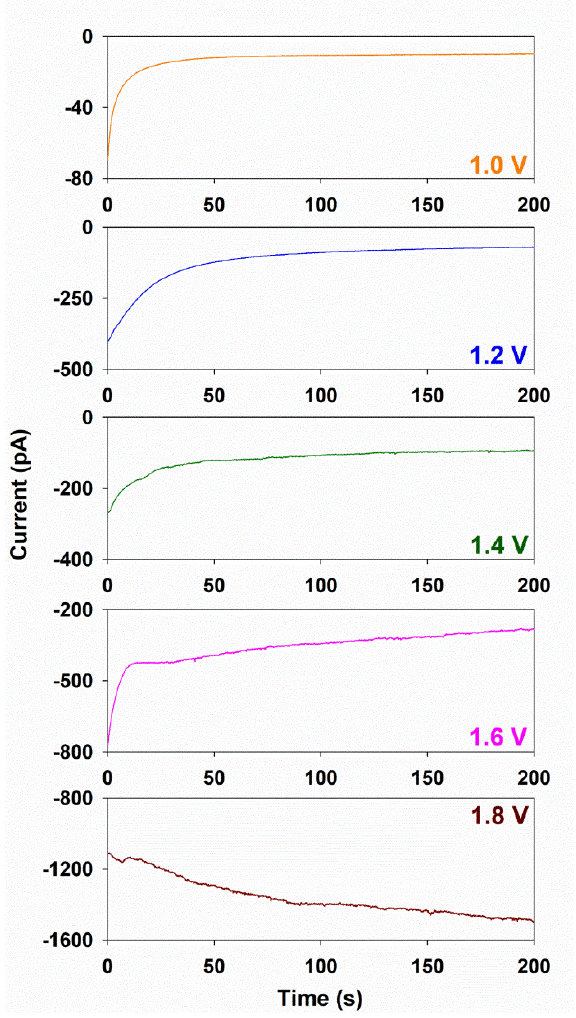
Figure 3. Amperometric i – t curves of W/O emulsion droplets on Pt-UME at various applied poten- tials (1.2, 1.4, 1.6, 1.8, and 2.0 V vs . Ag/Ag + ) in pure DCE solution. tials (1.2, 1.4, 1.6, 1.8, and 2.0 V vs . Ag/Ag + ) in pure DCE